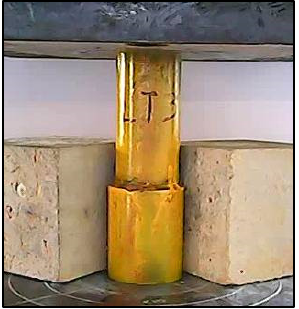
Figure 17. Sleeve shear experimental device.